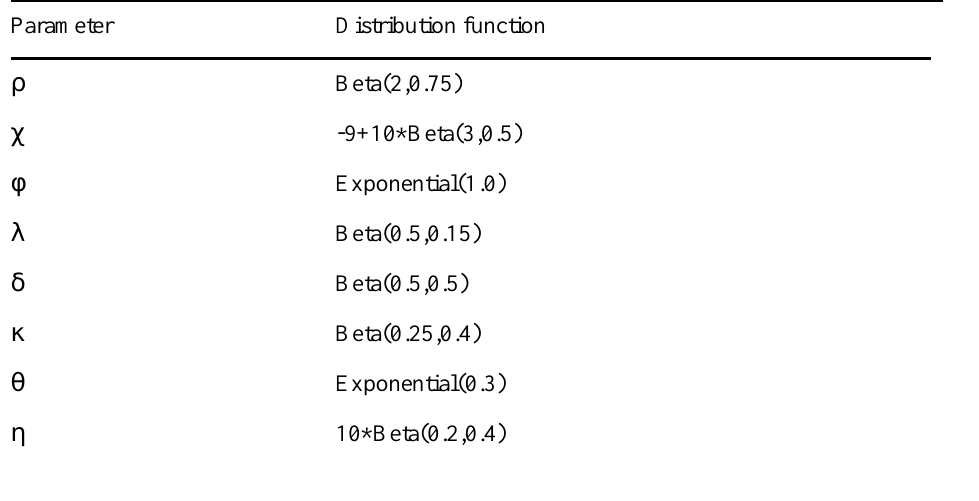
Table 7 . Simple distribution functions of the parameters of the